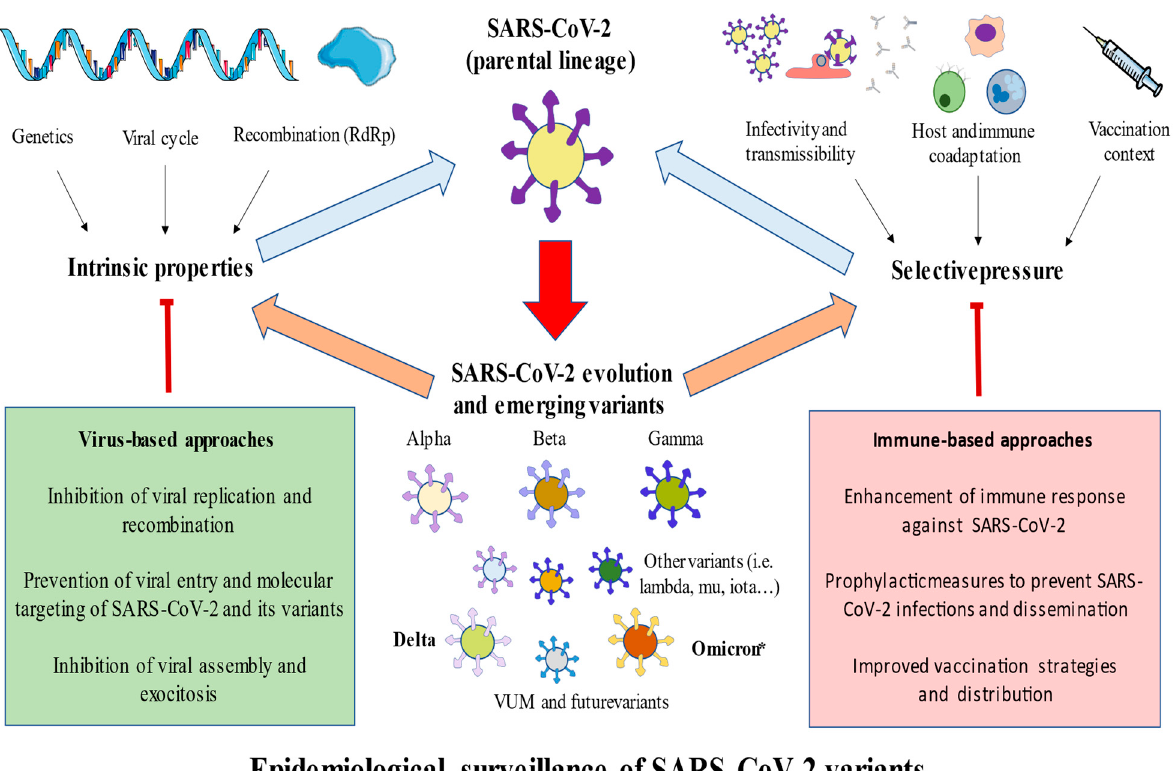
Figure 2. A general picture of the evolution and emergence of SARS-CoV-2 variants. As shown, due to the intrinsic properties of the virus (genetics, recombination, and viral cycle) and selective pressure (host and immune coadaptation, infectivity and transmissibility efficacy, and the actual vaccination context), a set of variants has been developing with enhanced features compared to their parental lineages, including greater transmission, infection rates, or circulation. Of them, currently Delta and Omicron are considered VOCs, where Omicron * represents the dominant variant worldwide. Simultaneously, there may be novel variants appearing, as well as further lineages of previously established variants. To limit the impact and slow the continuous evolution of SARS-CoV-2, virus- and immune-based approaches and, more prominently, prophylactic measures and improved vaccination strategies are needed. Table 1. A summary of the main SARS-CoV-2 variants.